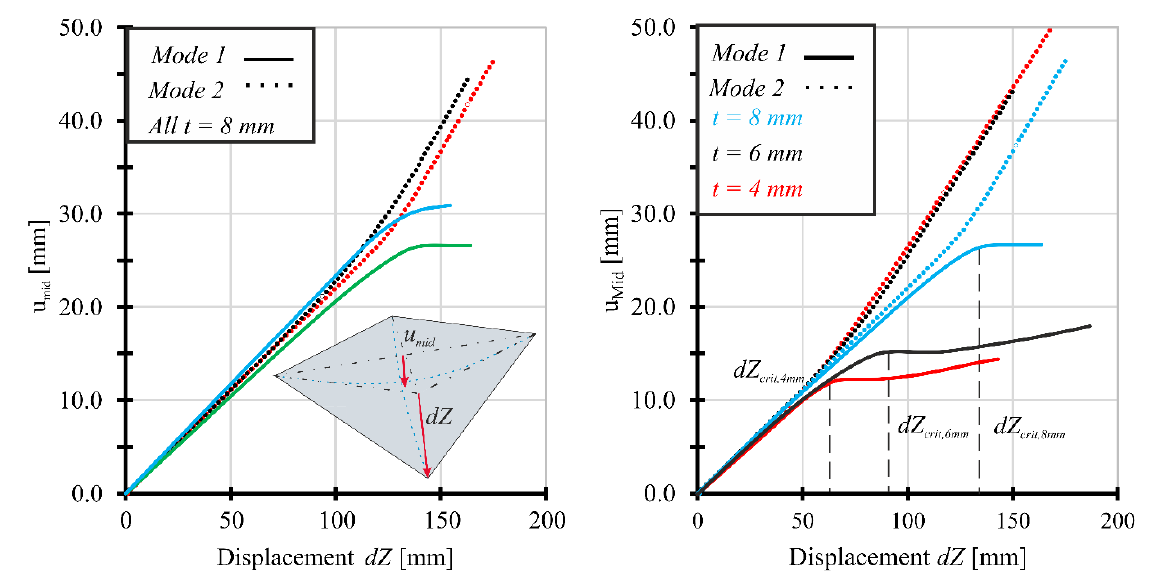
Fig. 4 Experimental midpoint deflection u mid vs. corner displacement dZ diagrams: (left) Depiction of the two possible modes on 8 mm panes (right) Influence of the thickness on the moment of shape